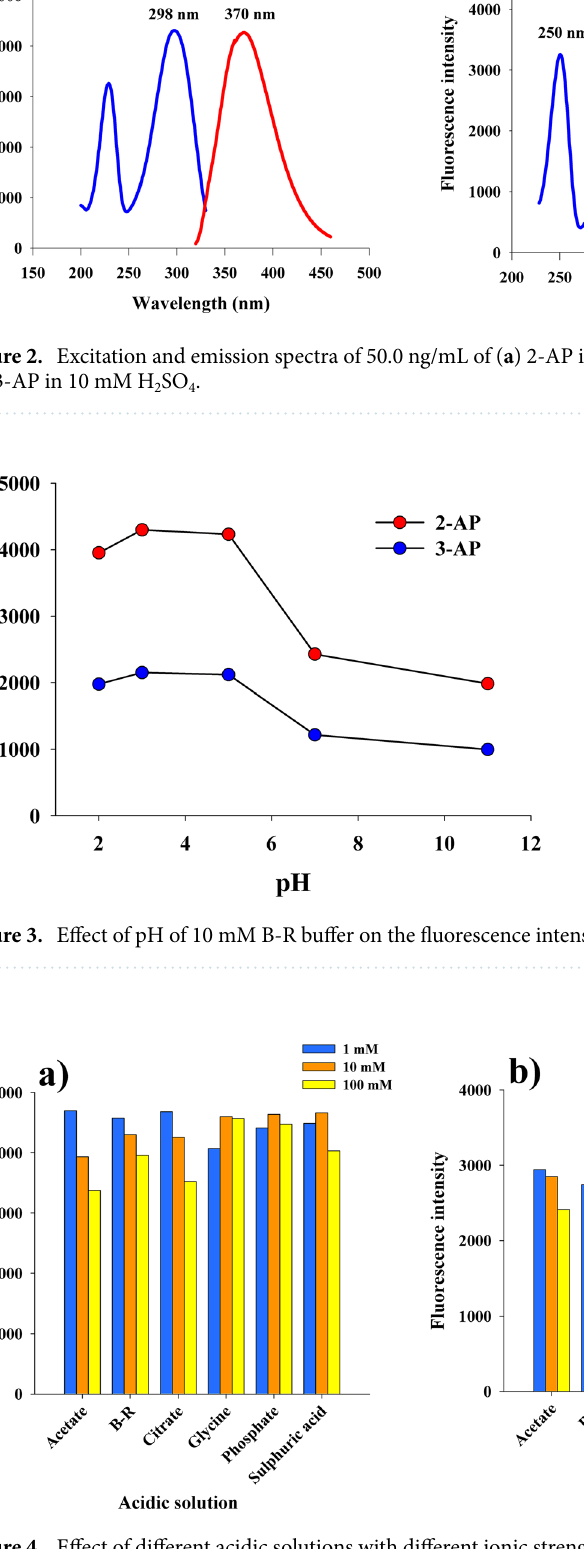
Figure 4. Effect of different acidic solutions with different ionic strengths on the fluorescence intensities of 50 ng/mL of ( a ) 2-AP and ( b )